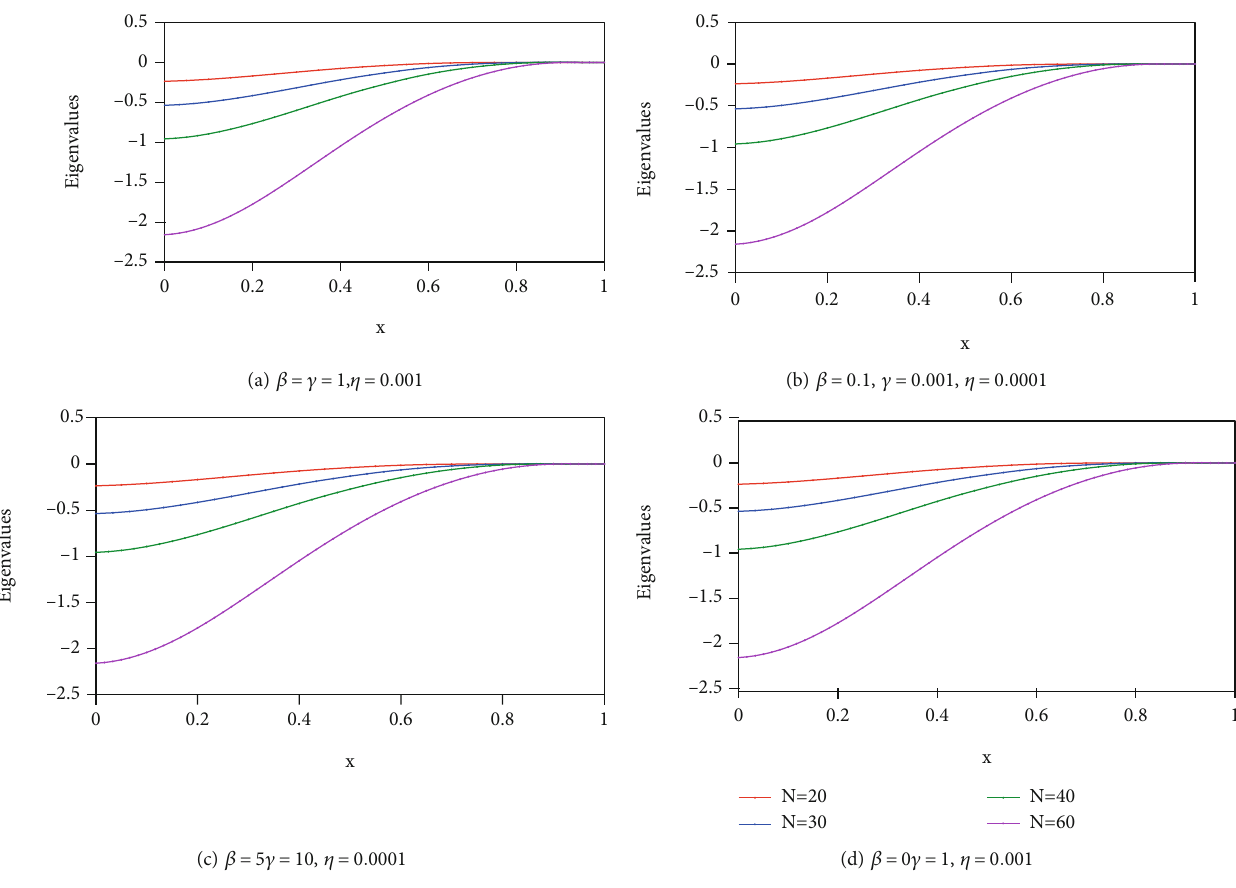
Figure 2: Plot of eigenvalues corresponding to gBH equation with Δ t = 0 : 0001 and δ = 8